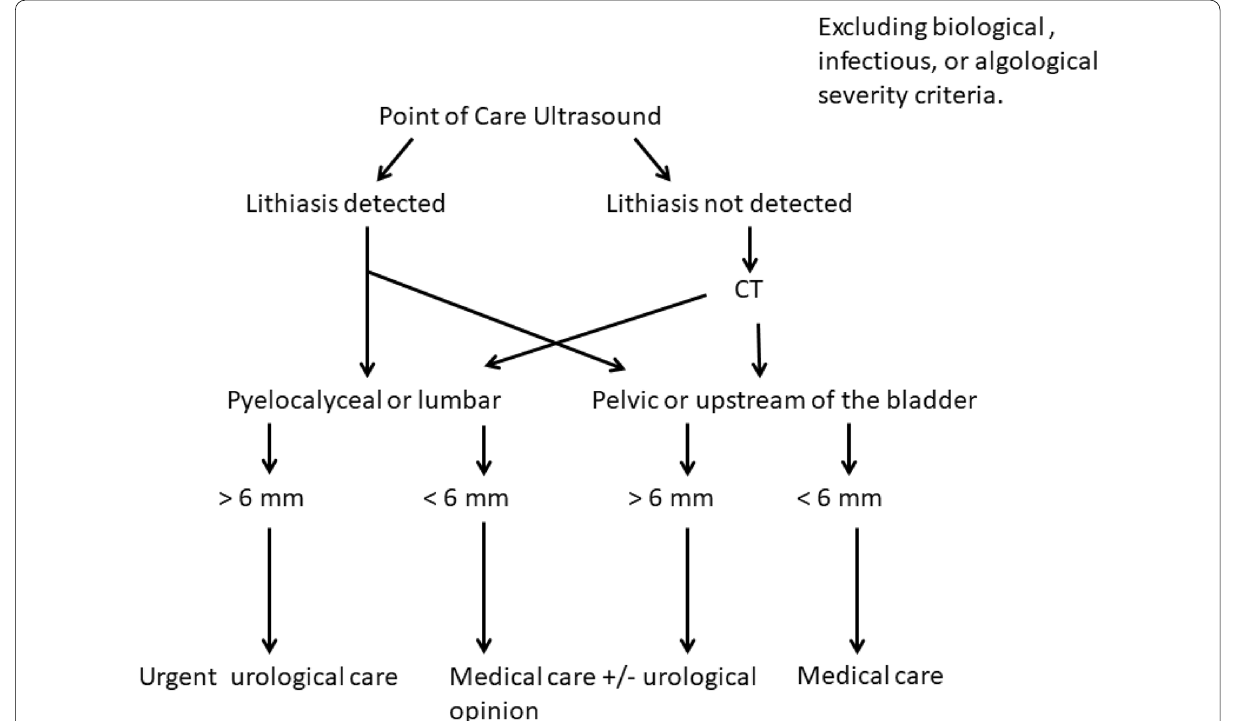
Fig. 4 Use of imaging (PoCUS and CT) for the management of patients presenting with ureteral